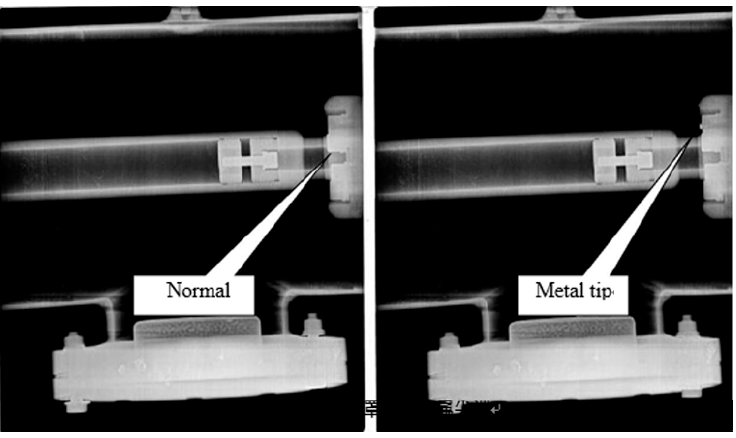
Figure 16. Metal tip in the grading shield.